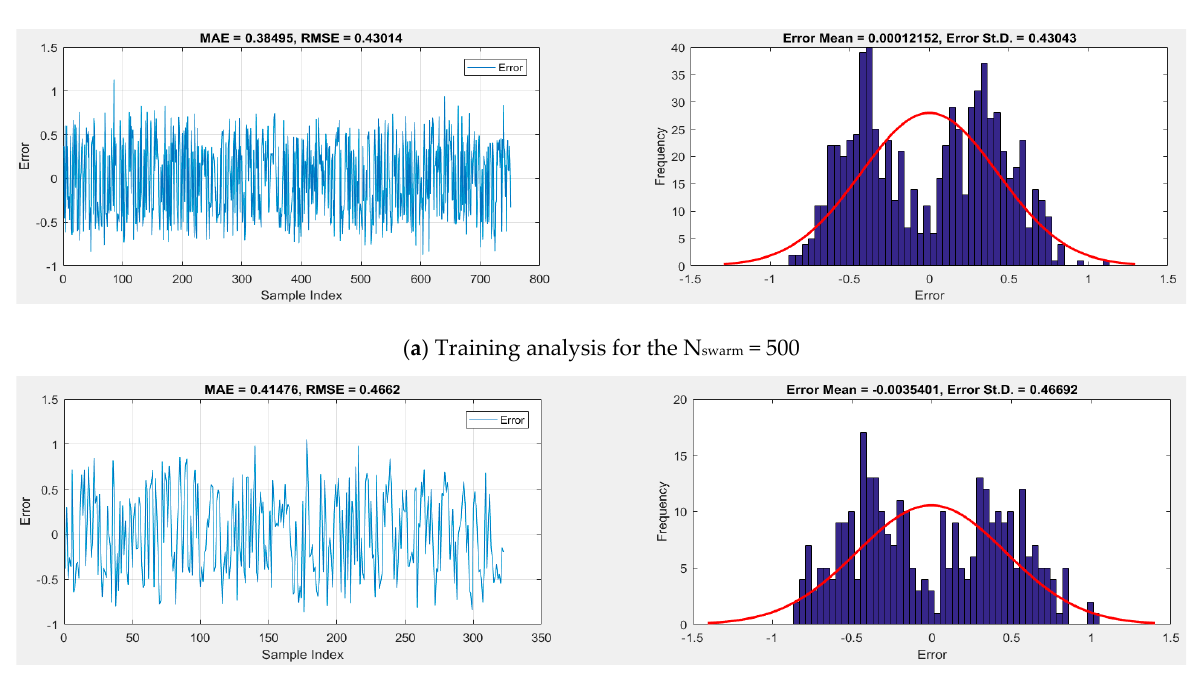
Figure 11. BBO-MLP Training and testing analysis.